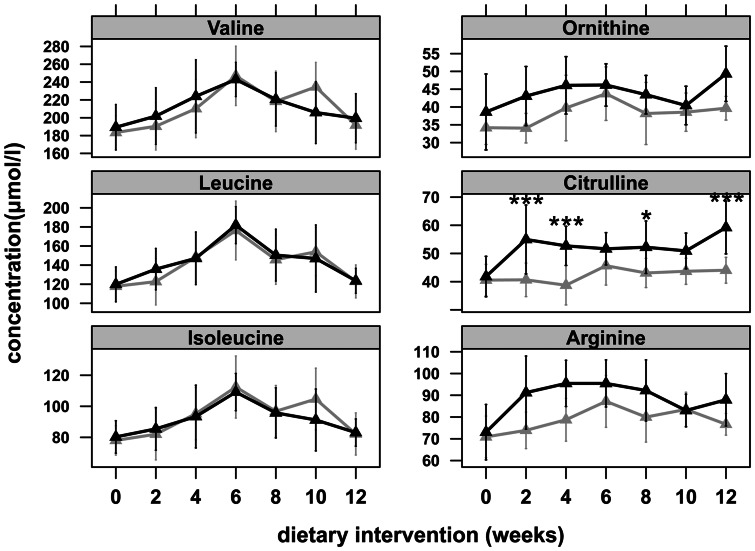
Time-courses of selected plasma amino acid concentrations during 12 weeks of HF dietary intervention in study 1.Grey and black lines represent C (n = 12) and HF animals (n = 12) feeding either a 10 energy% C diet or a 45 energy% HF diet for 12 weeks, respectively. Mice were fasted for 5 hours before they were sacrificed. Data are presented as mean ± SD. Asterisks indicate statistical significance based on two-way ANOVA followed by pairwise comparison using Tukey test. *p<0.05, ***p<0.001.